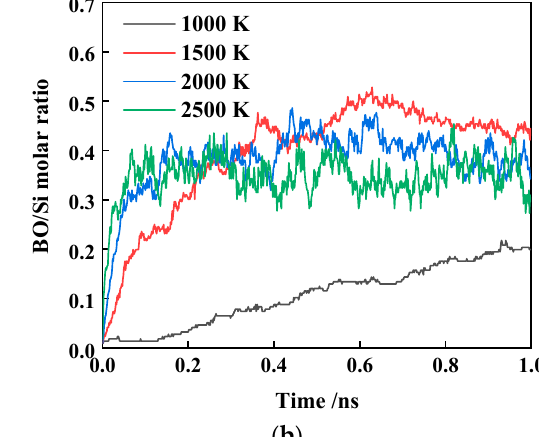
Figure 7. BO/Si molar ratio of C-S-H by different C/S ratios and temperatures. ( a ) C/S = 1.1; ( b ) C/S = 1.8.